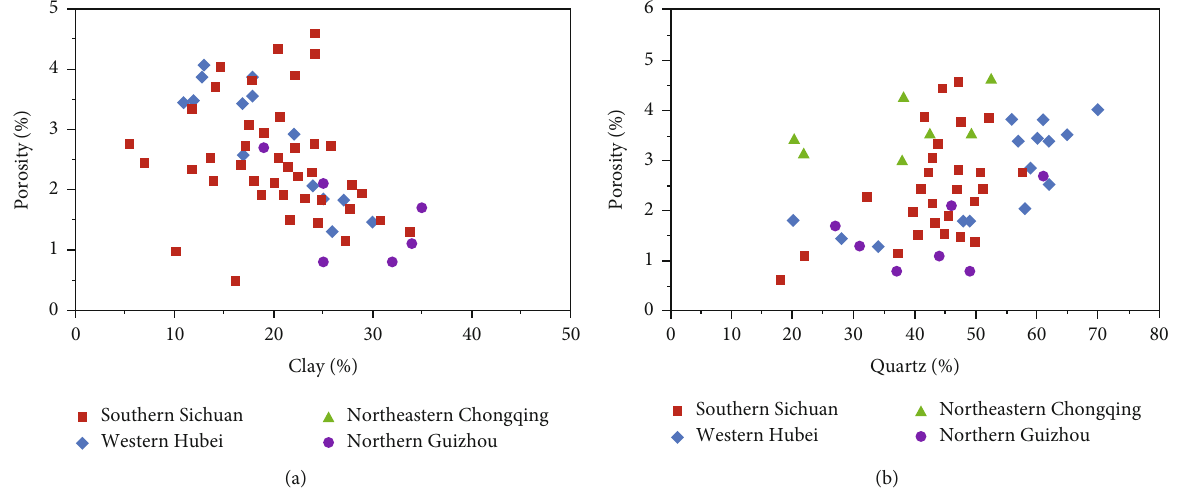
Figure 10: Cross-plots of the porosity versus (a) clay minerals and (b) quartz content of the Lower Cambrian shales in southern China (data from Li et al. [56]; Wang. [86]; Wei et al. [120]; Zhu et al.